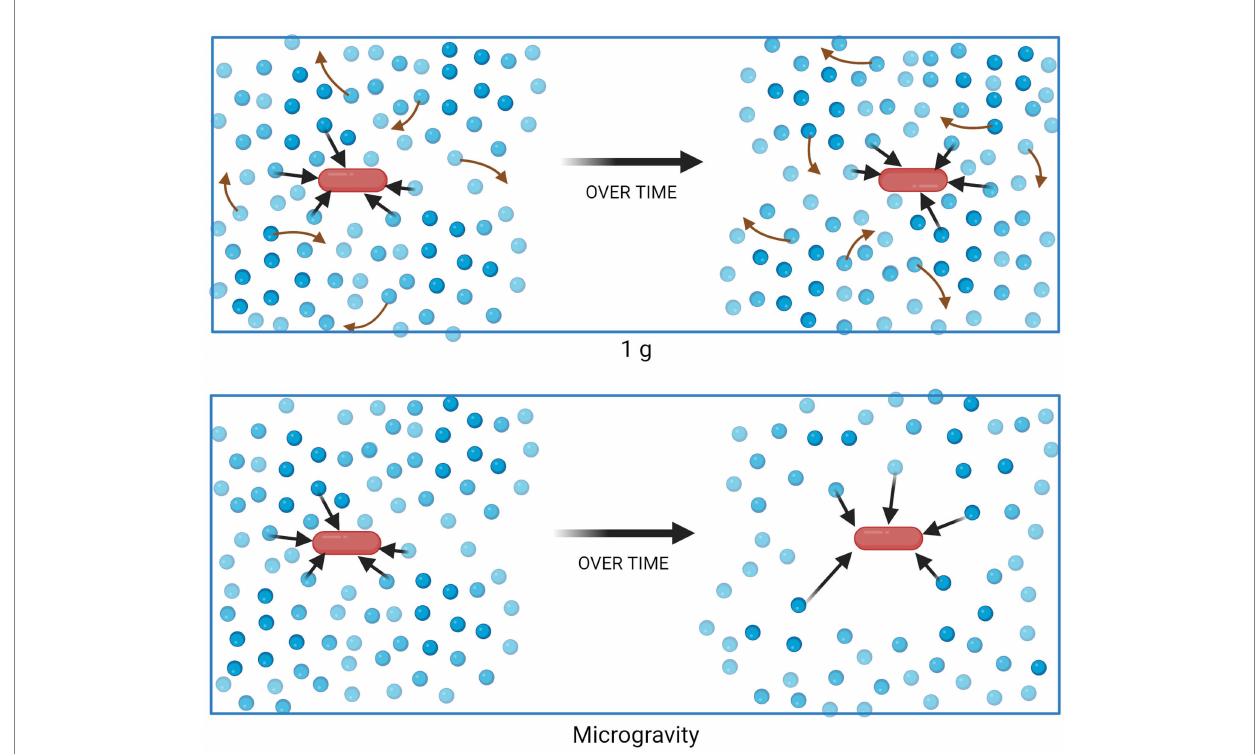
FIGURE 1 Nutrient uptake and distribution in a suspension culture in 1 g (top) and microgravity (bottom). Blue circles represent molecules of a growth substrate, consumed (black arrows) by the red bacterial cell. Red arrows represent mixing of substrate due to density-driven convection, which does not occur in quiescent fluids in microgravity. Figure generated using